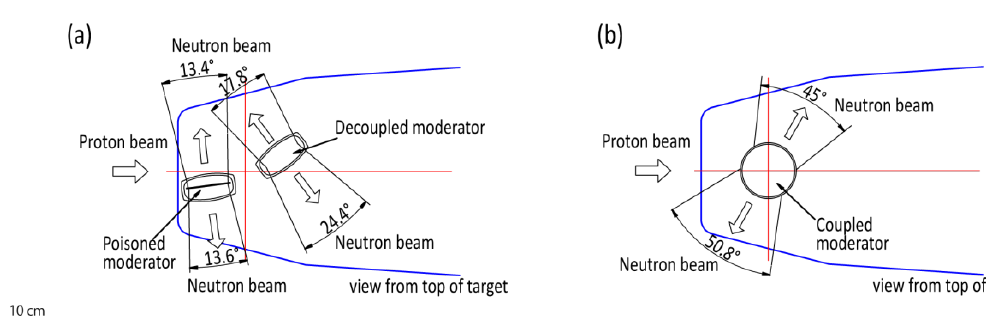
Figure 9. ( a ) Locations of decoupled and poisoned moderators with respect to the target vessel. ( b ) Location of coupled moderator with respect to the target vessel. The directions and angles of neutrons extracted from each moderator surface to neutron beamlines are also shown. Quantum Beam Sci. 2017 , 1 , 8